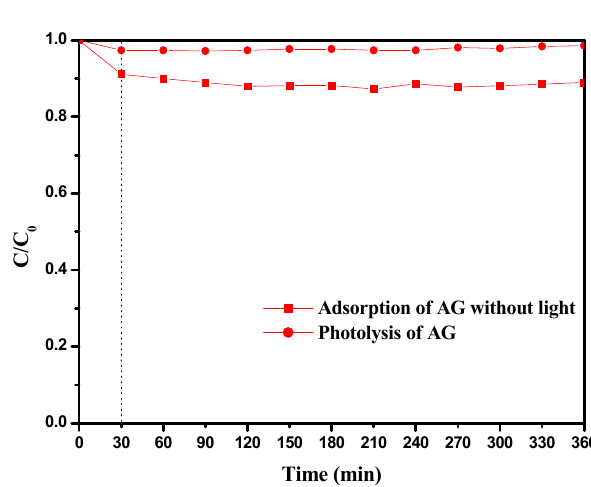
Figure 11. Absorbency standard curve of AG.